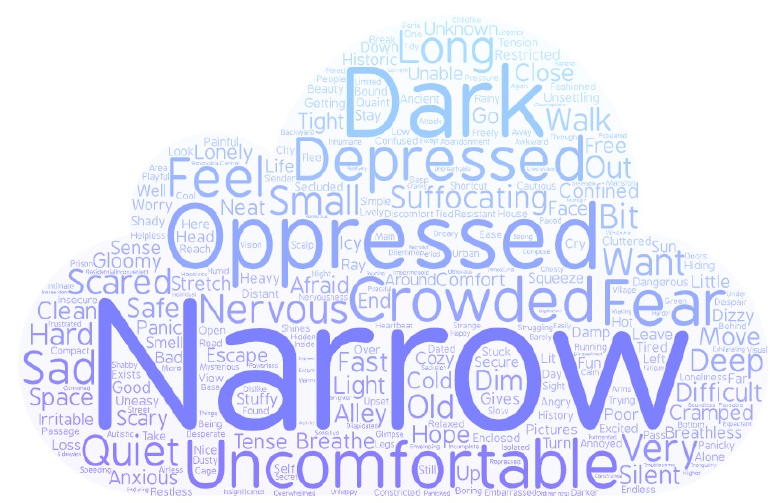
Figure 6. The word clouds in the narrow environment.